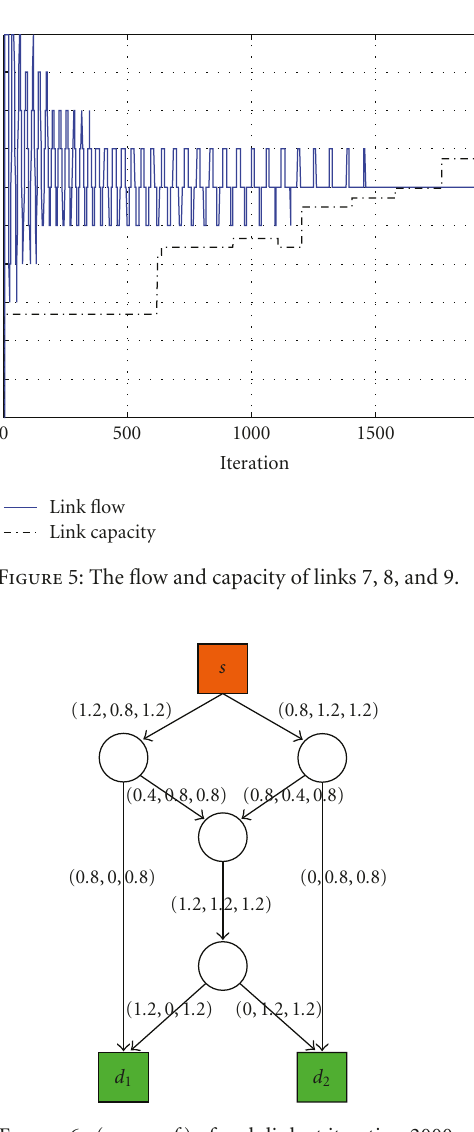
Figure 6: ( e i , l , e 2, l , f l ) of each link at iteration